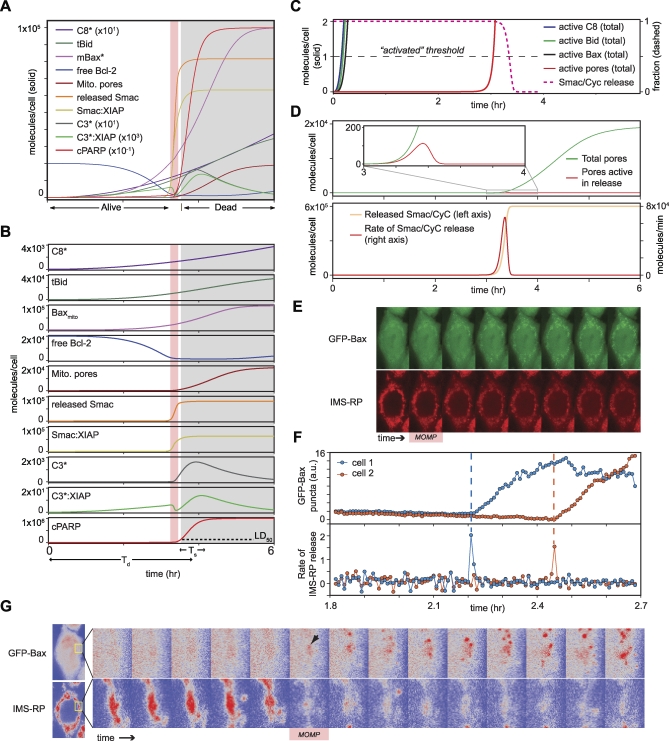
Prediction of the Transition from Graded to Switch-Like KineticsFor simplicity, positive feedback was omitted in all simulations by setting [C6]0 = 0; results with positive feedback produce highly similar conclusions and can be found in Figure S4.(A) Overlay of multiple species. To accommodate the wide range of concentrations, some species are scaled according to the values in parentheses in the caption.(B) The same data as in (A) except that each vertical axis is scaled independently to better depict the full dynamic range for each species. The pink vertical line denotes the duration of MOMP. The estimated LD50 for caspase activity (corresponding to ∼10% PARP cleavage) [15] is denoted by a dashed line in the cPARP plot; the gray shaded region denotes points in time after this lethal dose has been reached and cells are already destined to die.(C) Simulated time courses for C8*, tBid, Bax*, and mitochondrial pores as in (A) shown on a truncated vertical axis to display the times at which each species achieves a concentration of one molecule/cell. The full time course for mitochondrial Smac/CyC is shown as a dashed line on a full vertical axis (right) to show MOMP.(D) Top panel, simulation of the total number of MOMP pores as in (A) (green) in comparison to the subset of pores bound to Smac or CyC during the process of release (red). Bottom panel, simulation of released Smac/CyC as in (A) (pink) and the discrete-time derivative of the release reaction (red).(E) Live-cell imaging of IMS-RP (red) and GFP-Bax (green) in the same cell. Frames correspond to 30-s intervals, with the first frame of MOMP denoted by a pink box. Partial mitochondrial localization of IMS-RP following MOMP is an artifact of the overexpressed reporter; endogenous CyC is fully cytosolic at this point, as determined by immunofluorescence (not shown).(F) Quantitation of Bax pores (top) and rate of IMS-RP release (bottom) for two cells (orange curves correspond to the cell shown in [E]); puncta and rate of release were quantified as described in Materials and Methods.(G) Live-cell images for the cell in (E) shown at higher zoom and with pseudocoloring to highlight the temporal and spatial relationship between Bax puncta and IMS-RP release. Frames correspond to 30-s intervals; the magnified region (yellow box) encompasses the area of the cell in which both GFP-Bax puncta and IMS-RP release are first visible.